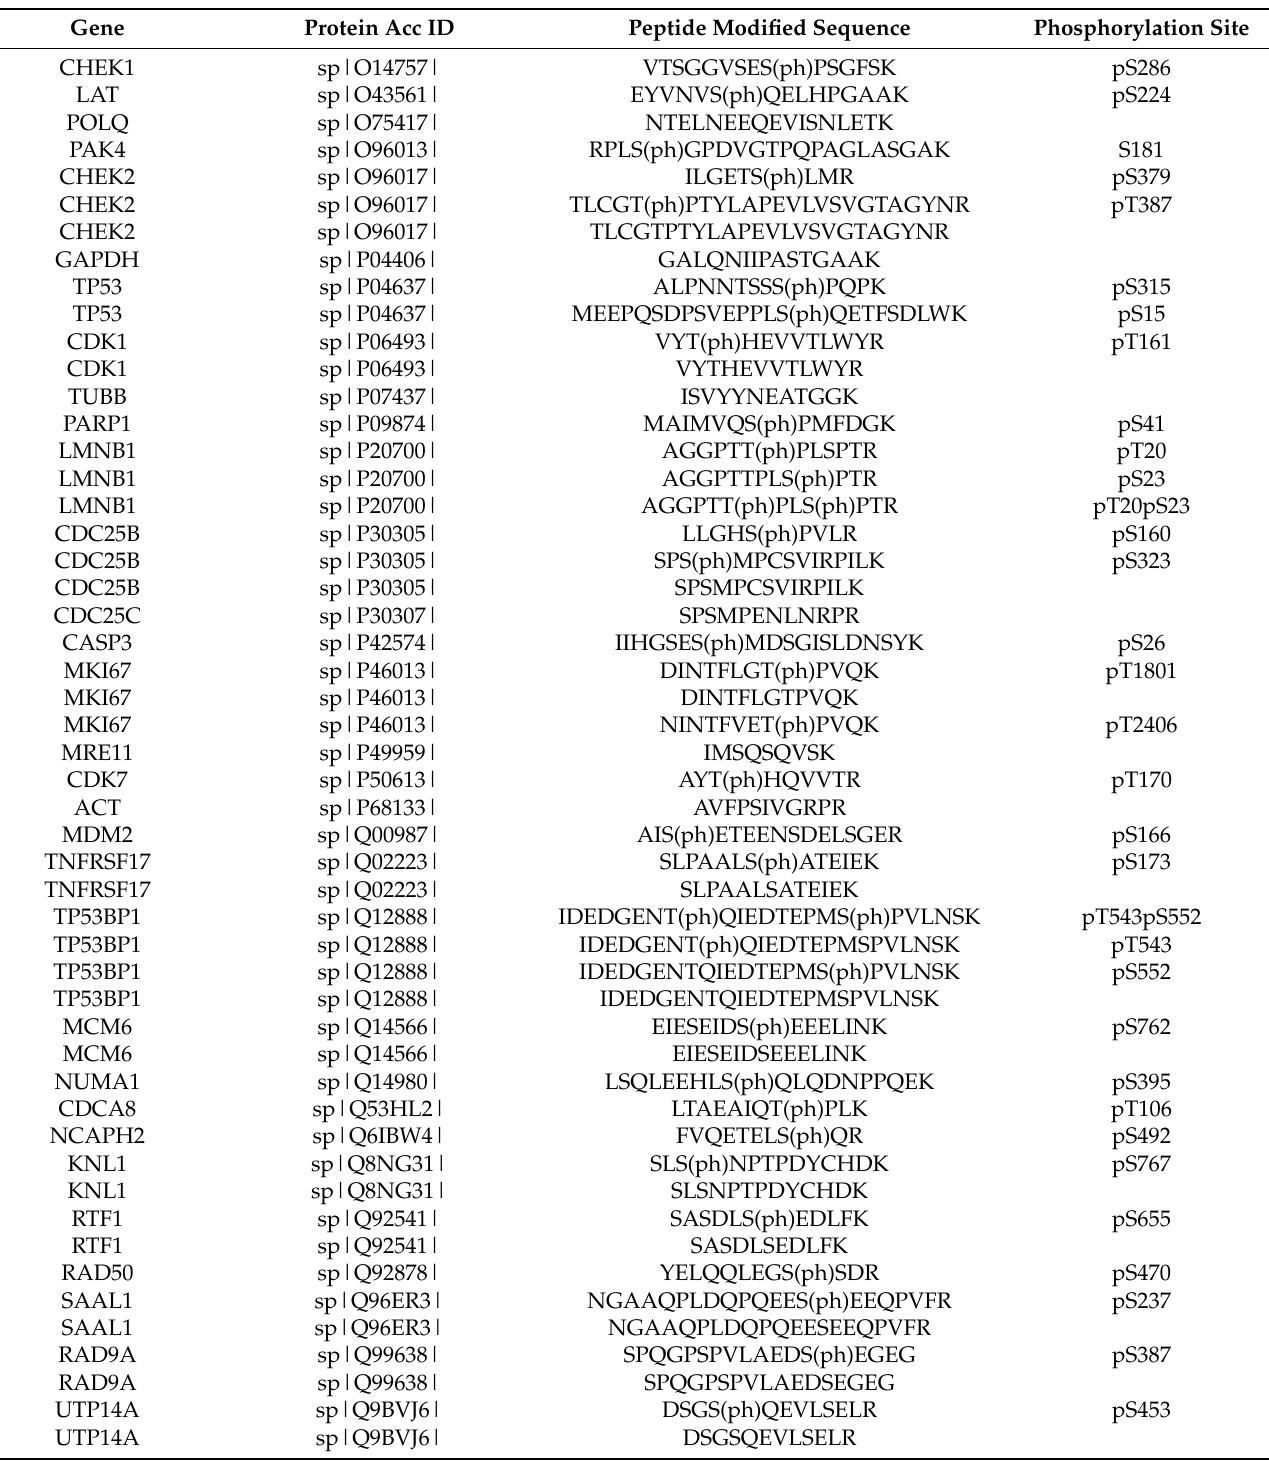
Table 1. Peptides targeted for the multiplexed DDR-2 immuno-MRM assay panel. Modifications of “(ph)” indicate phosphorylation. Site of phosphorylation refers to the amino acid position in the